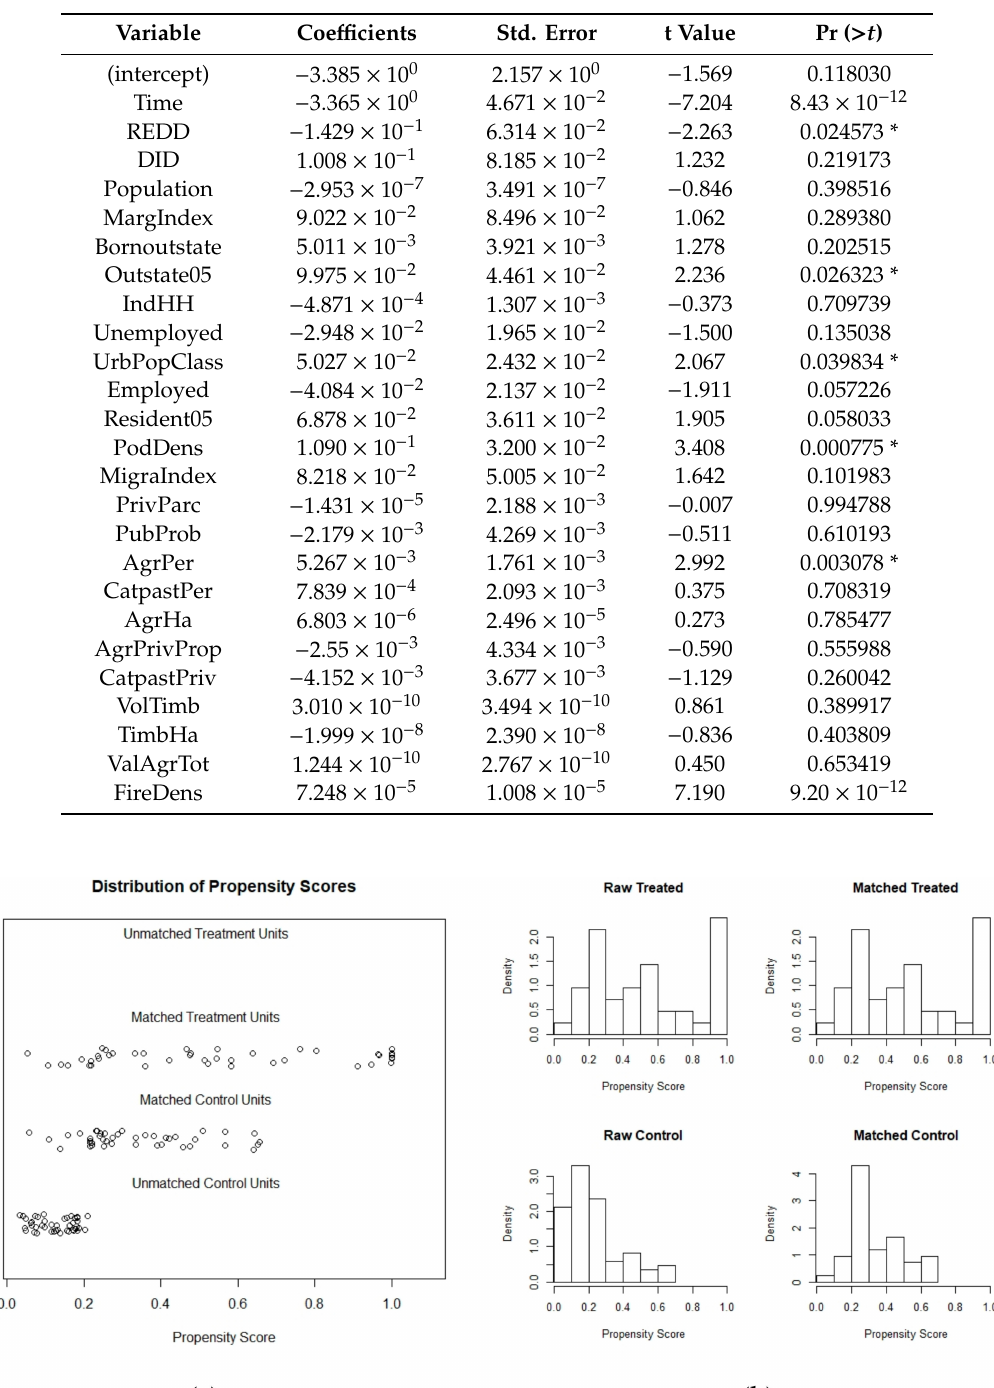
Table 2. Di ff erence-in-Di ff erence (DID) regression model results for municipal-scae analysis of REDD + e ff ectiveness in reducing forest cover loss on the Yucatan Peninsula (* p < 0.05).